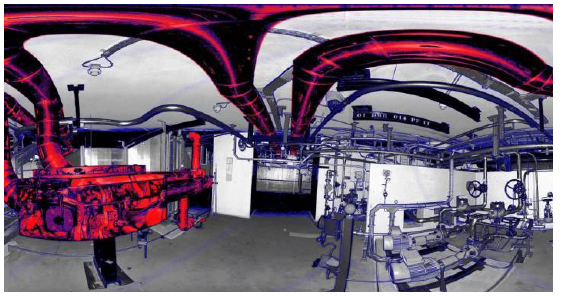
Figure 4: result of the manual segmentation of outliers in a scan due to object high reflectance. Red : points removed from the spherical view before publication in a measurement tool for non familiar users. Blue : points removed by automatic filters. Grey levels : points kept for distance measurements.